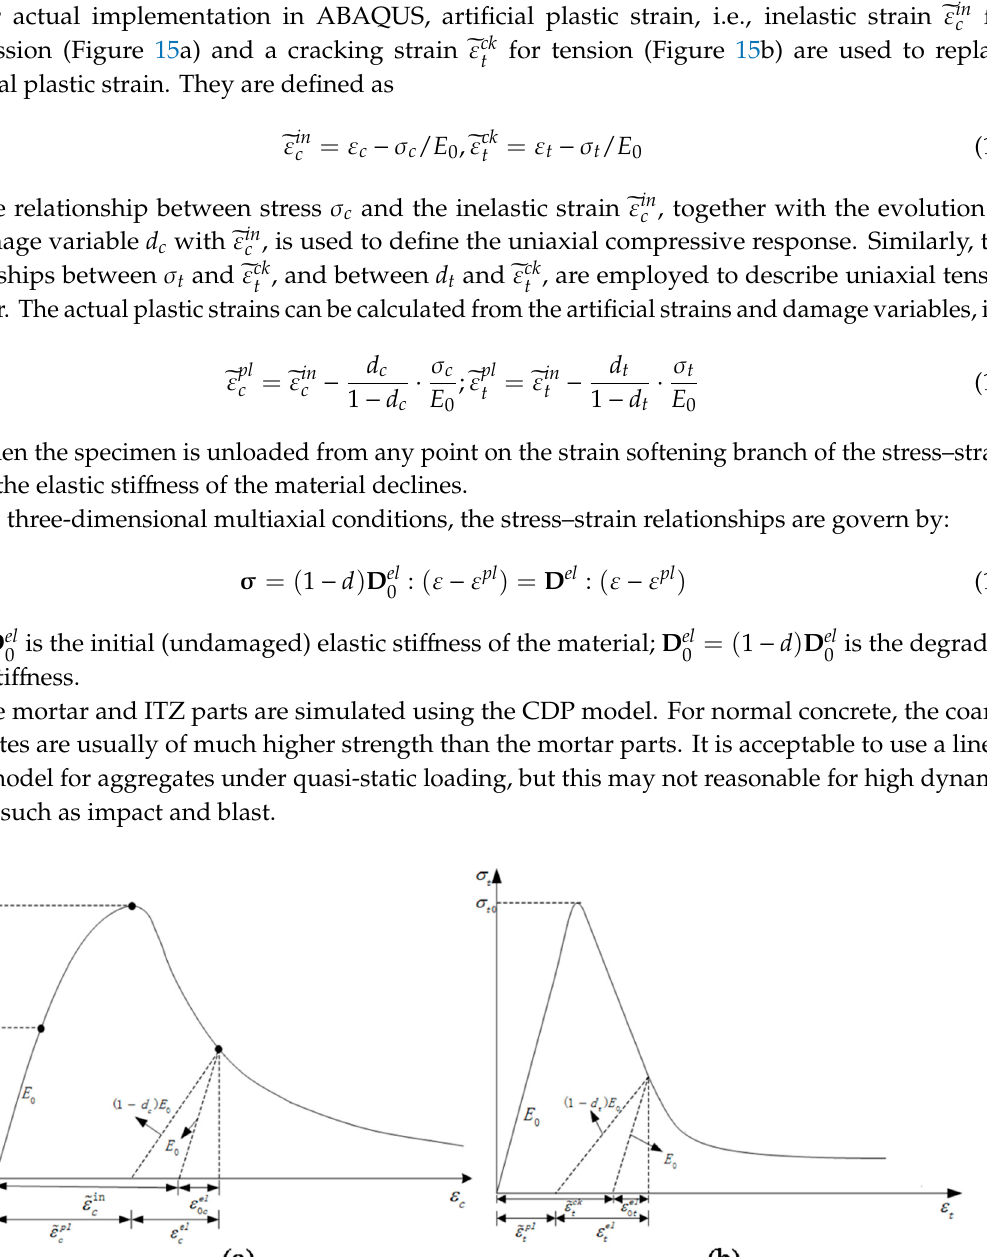
Table 3. Grain size of aggregates in Section 3.